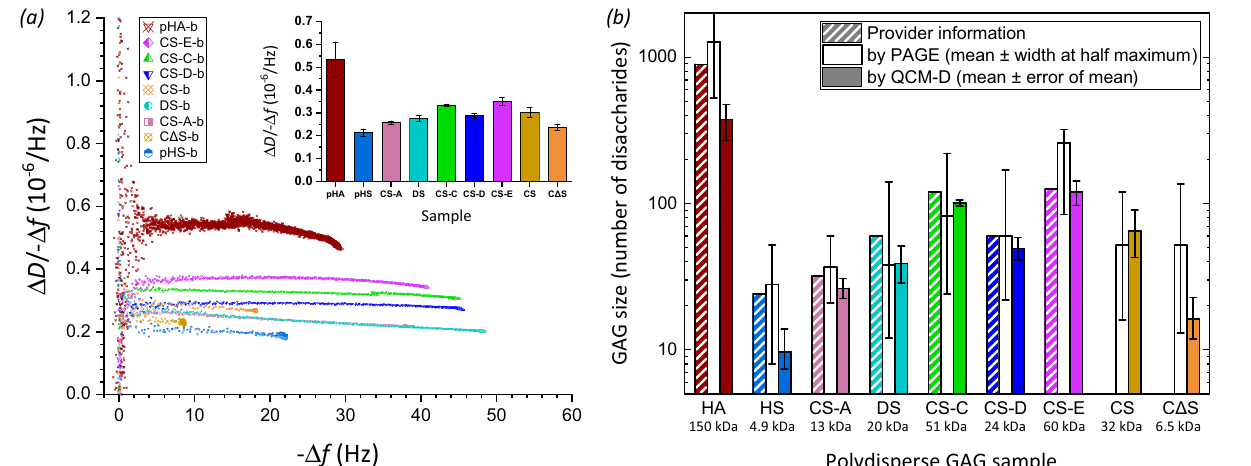
Figure 6. Application examples of chain sizing natural, isolated GAG preparations. ( a ) Plot of the Δ D /− Δ f ratio versus − Δ f ( i = 3; frequency shifts are normalised by i ) for various polydisperse GAG-b polysaccharide preparations of HA and other GAG types (chondroitin sulfate – CS, CS-A, CS-C, CS-D and CS-E, chemically desulfated CS—CΔS, dermatan sulfate – DS, heparan sulfate – HS; symbols and colour codes as indicated). Original QCM-D data are shown in Fig. S9. The inset shows the Δ D /− Δ f values at − Δ f = 2.5 Hz, as mean ± standard deviations for − Δ f values ranging between 2 and 3 Hz. ( b ) Comparison of the effective size (in number of disaccharides n ds ) of surface-grafted GAG-b polysaccharides (as determined by QCM-D; filled bars) with the effective size distribution of GAG-b polysaccharides in solution (as determined by PAGE; unfilled bars) and the size estimates of the original GAGs given by the provider (bars with diagonal lines; taking disaccharide masses to be 400 Da for HA, and 500 Da for all sulfated GAGs). To calculate GAG sizes from QCM-D data, the Δ D /− Δ f values at − Δ f = 2.5 Hz of the polydisperse GAG-b preparations were compared with the standard curve (Fig. 4 and Eq. 1). To calculate the effective size distribution from PAGE data, the migration distances of the peak intensity and the half-maximal intensities above background were compared to the migration distances of size-defined HA standards (Fig. S8). The effective molecular masses of surface-grafted GAGs (in kDa) are given below the GAG names, and were derived from n ds with disaccharide masses of 400 Da for HA and CΔS, and 500 Da for all sulfated